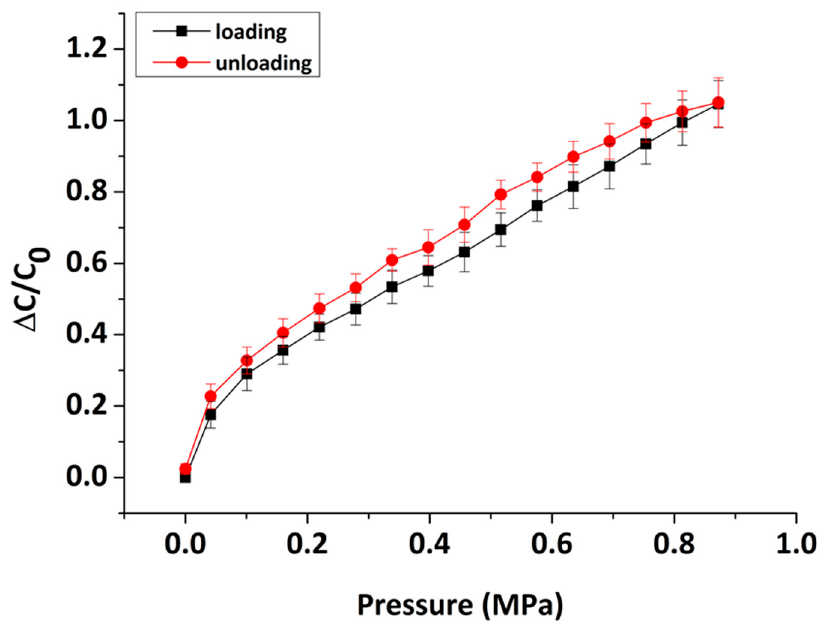
Figure 9. Hysteresis curves of the sensor obtained from three consecutive linear loading–unloading cycles of pressure.